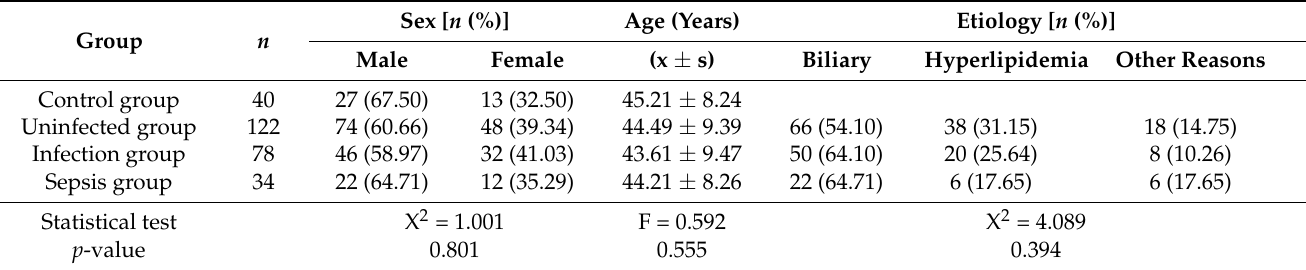
Table 1. Comparison of basic data of patients in each